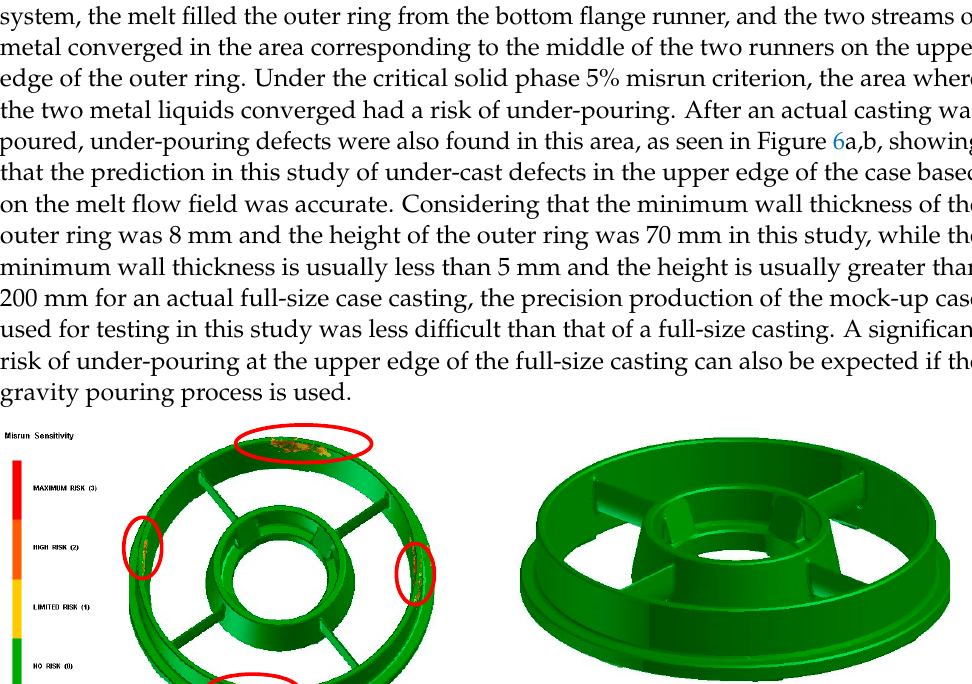
Figure 6. the pictures of TiAl cases. Using a 4× cross runner, misrun defects were found in the area corresponding to the middle of the two runners on the upper edge of the outer ring in ( a , b ). Using an 8× cross runner, no misrun defect was found on the upper edge of the outer ring in ( c , d ). 3.3. Defects at the Runner of Thick and Large Flange The cross-sectional flange area of a casting is usually thicker and is therefore the pre- ferred location for internal runners. Conventional titanium cases usually use the flange for the location of internal runners. However, the TiAl alloy melt flow was an order of magnitude lower than that of titanium alloys, and the density was also 10% lower than that of titanium alloys. As a result, the defect-replenishment ability of TiAl castings was significantly reduced, and if the water runner structure is not set up properly, it would be easy for porosity defects to appear at the bottom of the runners. The results of the temper- ature field calculations showed that for the pouring systems with the 4× and 8× cross run- ners, there was a degree of overheating at the bottom of the runner (see Figure 7), which